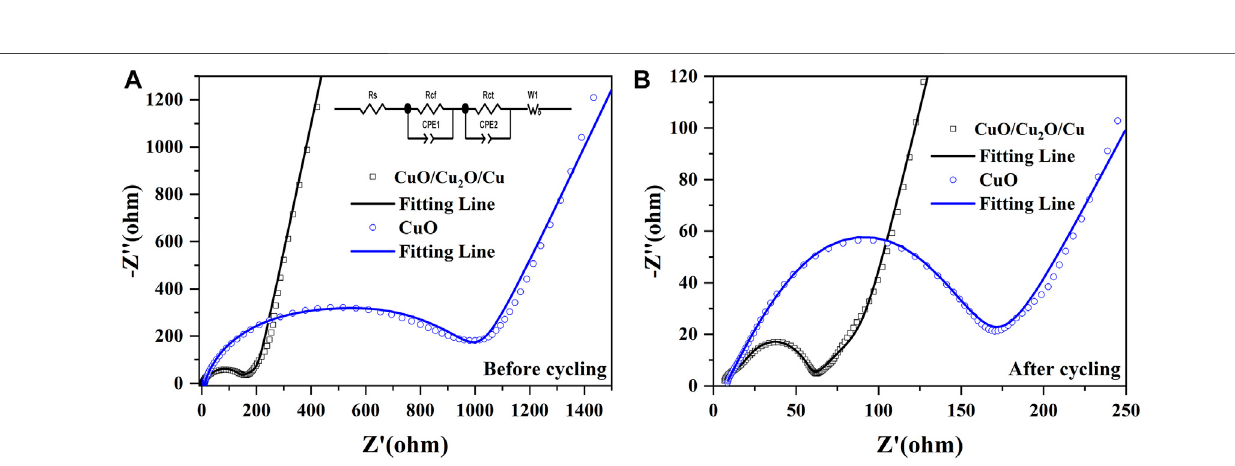
Frontiers in Chemistry |